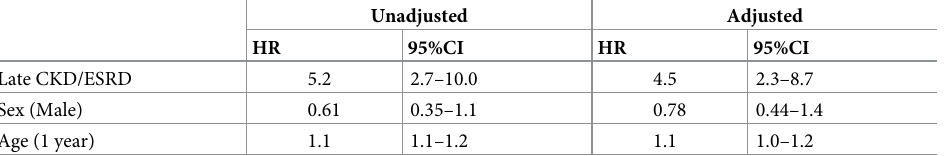
Table 4. Unadjusted and adjusted results from Cox Proportional Hazard Model for death or dialysis in patients diagnosed with late CKD/ESRD compared to early